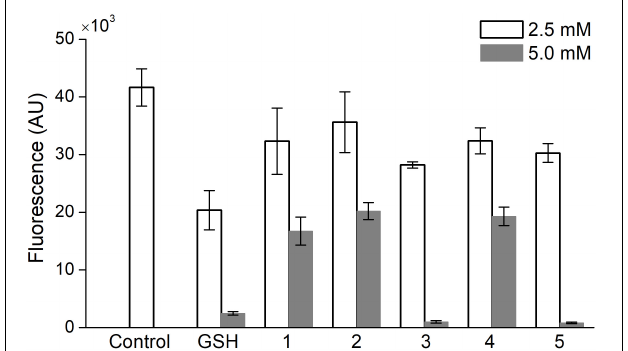
FIGURE 4 | Effect of 1-h incubation with oligopeptides on intracellular ROS level in PC-12 cells treated with H 2 O 2 (100 mM). Control – uninhibited ROS level, GSH – glutathione, (1) YRFK-NH 2 , (2) TPP-3-YRFK-NH 2 , (3) TPP-6-YRFK-NH 2 , (4) YrFK-NH 2 , (5) TPP-6-YrFK-NH 2 . Analysis was performed in HBSS with the use of DCFDA fluorescent probe. Mean ± SD are shown ( n =